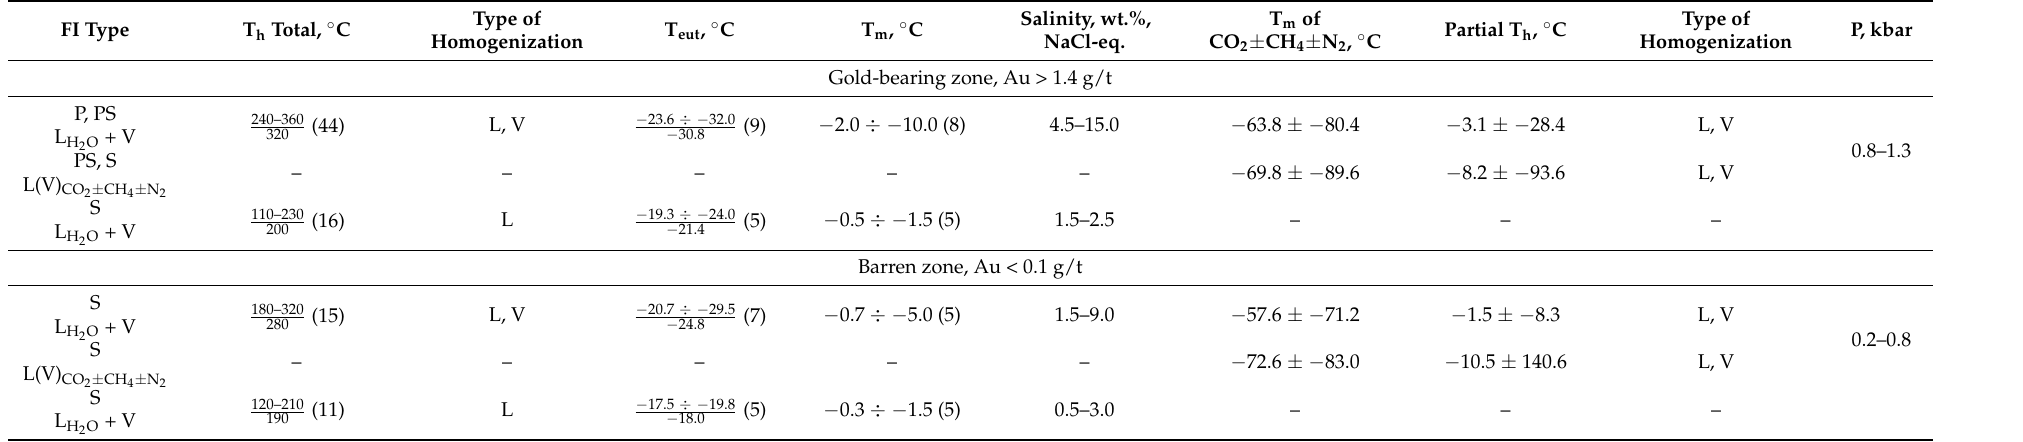
Table 1. Summary of fluid inclusion microthermometricdata from the Dobroegold